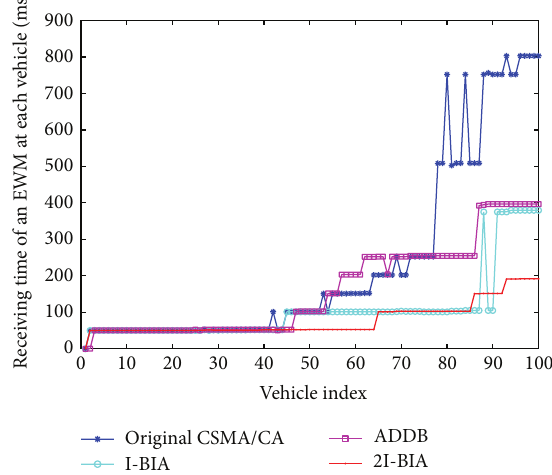
Figure 3: Receiving time of first EWM at each vehicle.